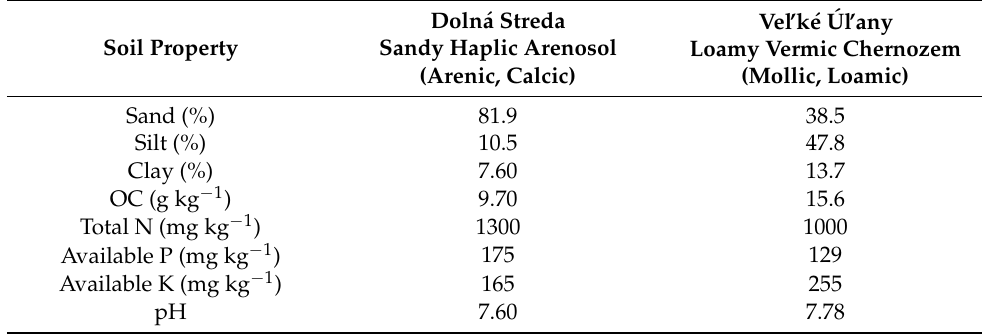
Table 2. The basic chemical and physical properties of the used biochar substrates BS1 and BS2. BS1 BS2 Pellets (dimensions in mm) 2 · 2 · 1 2 · 2 · 1 OC